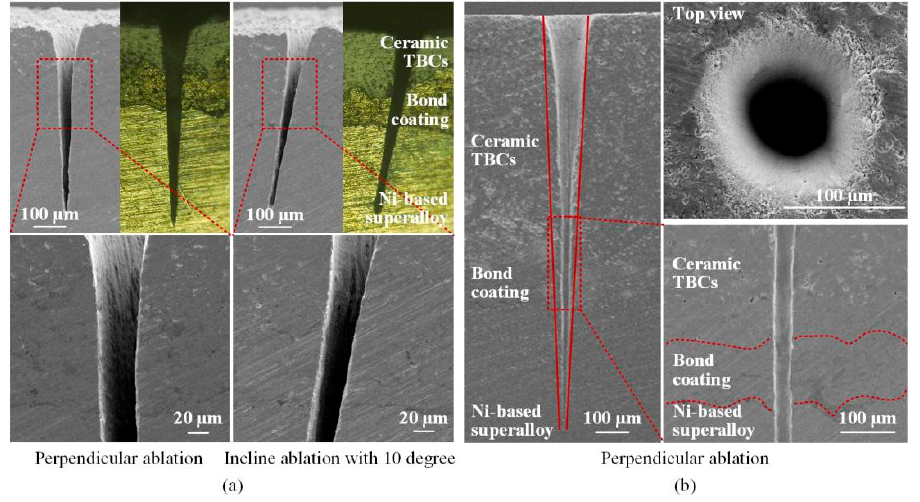
Figure 12. SEM and metallographic images of microstructures in Ni-based superalloy coated with ceramic TBCs. ( a ): Groove ablation ( b ): Hole drilling